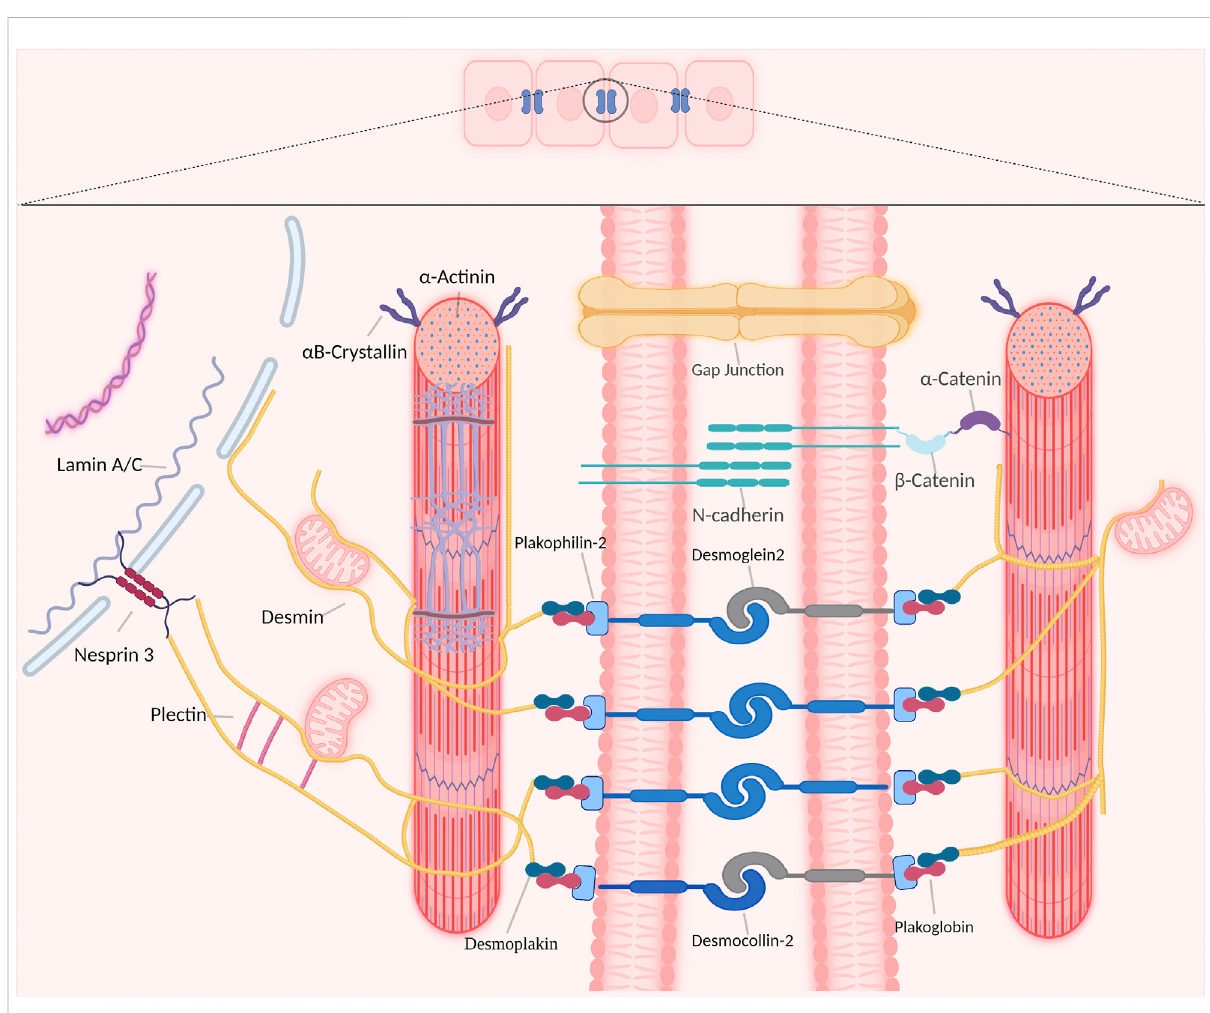
FIGURE 1 Overview of desmin network in and between cardiomyocytes. Desmin interacts with different organelles (including nucleus and mitochondria) and connects the entire contractile apparatus to different membranous compartments (such as sarcolemma, costameres and desmosomes of the intercalated disks) to form a continuous cytoskeletal intermediate fi laments